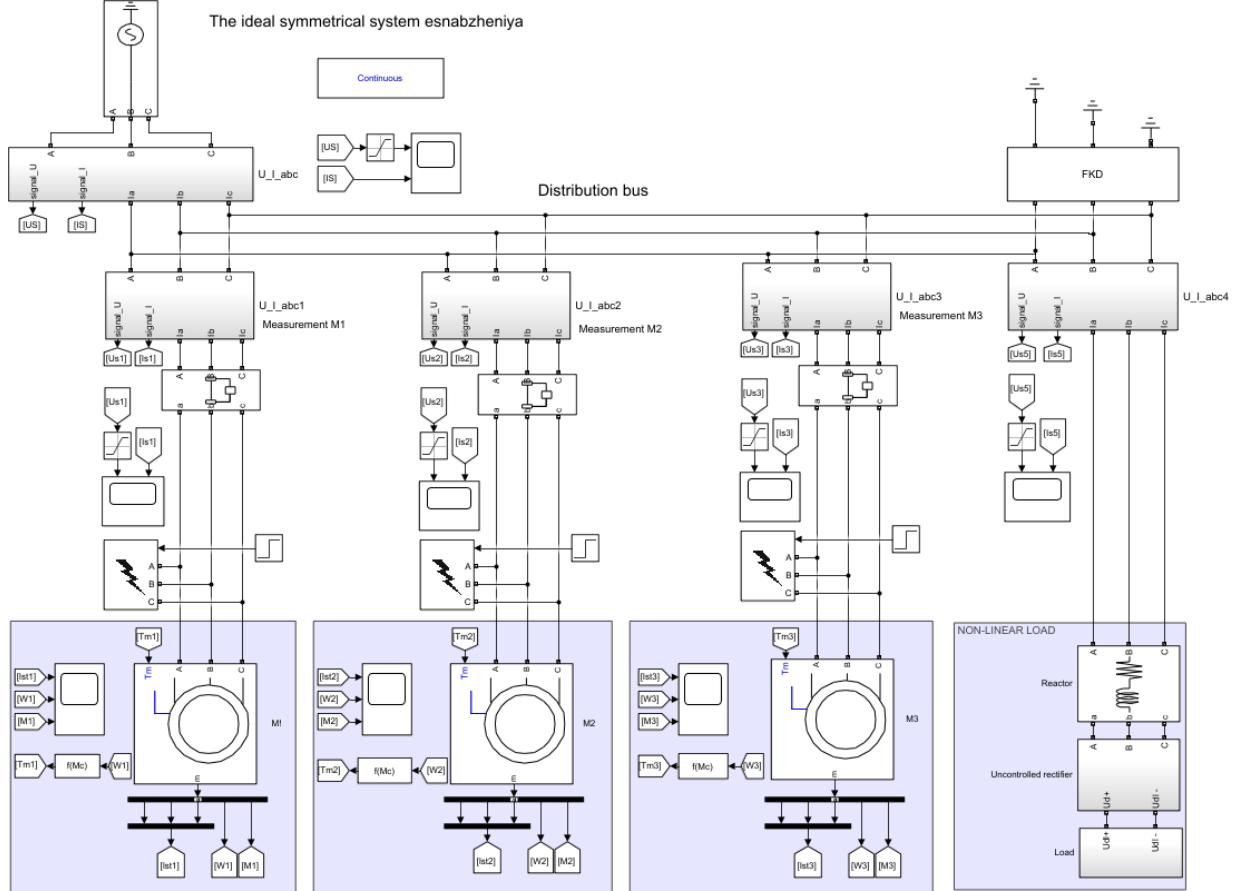
Figure 5. Simulation model of the power supply system for a group of induction motors.